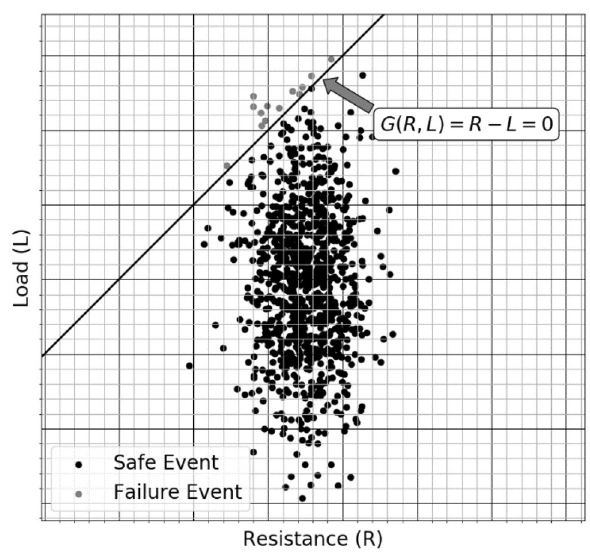
Fig. 1 Monte Carlo illustrative